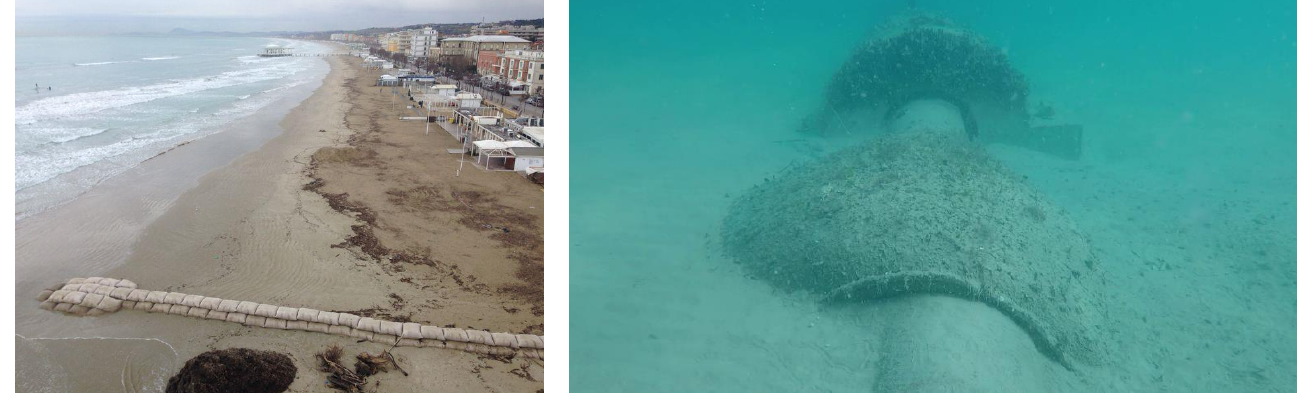
Figure 2. Application of “Stopwave” as temporary groin in Senigallia, Italy ( left panel ) or as pipeline protection ( right panel ).